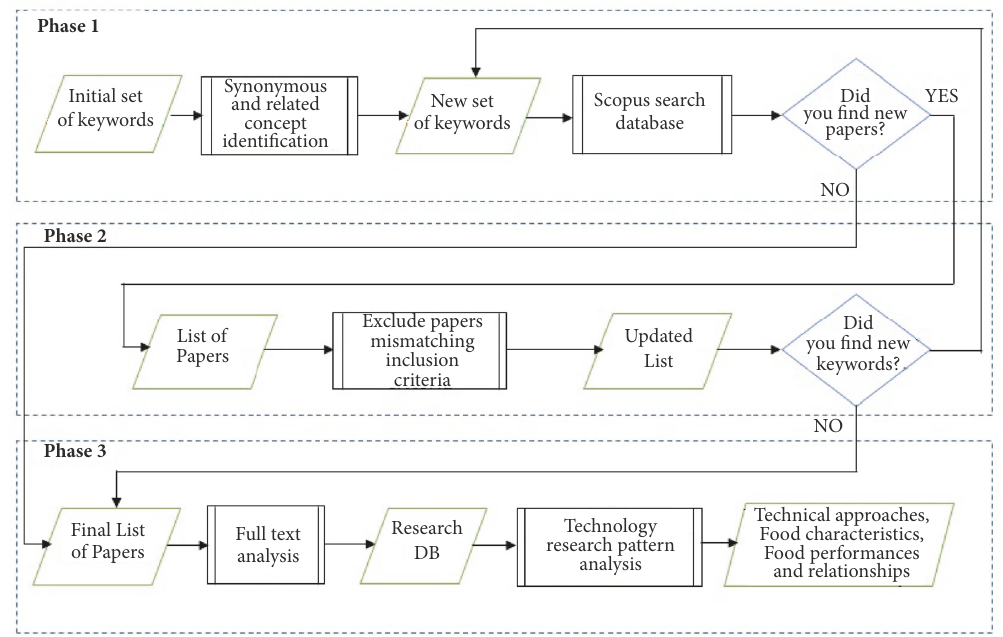
Figure 3: Systematic literature review workflow.